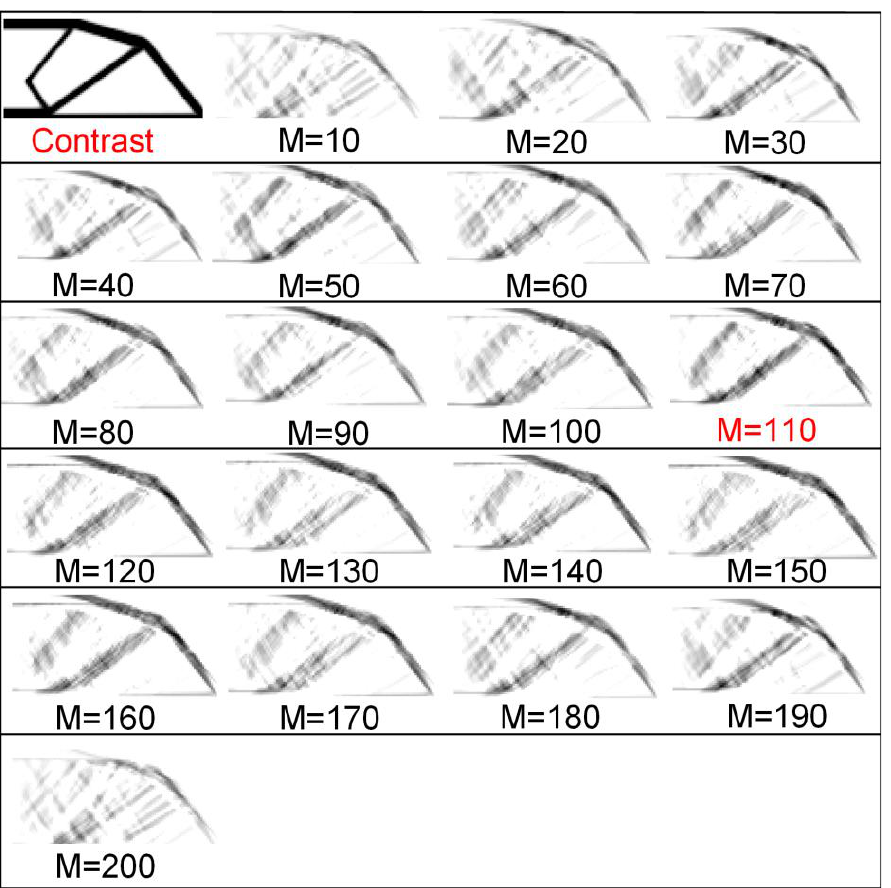
Figure 6. The prediction result of training 1 with different M.